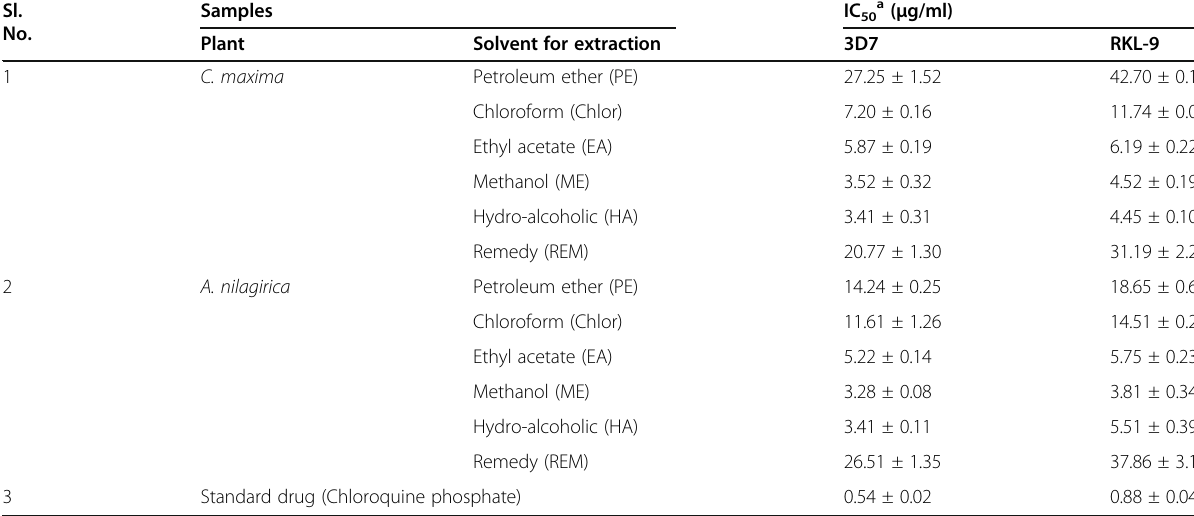
Table 1 IC 50 values of the plant extracts against 3D7 and RKL-9 strains of P. falciparum Sl.